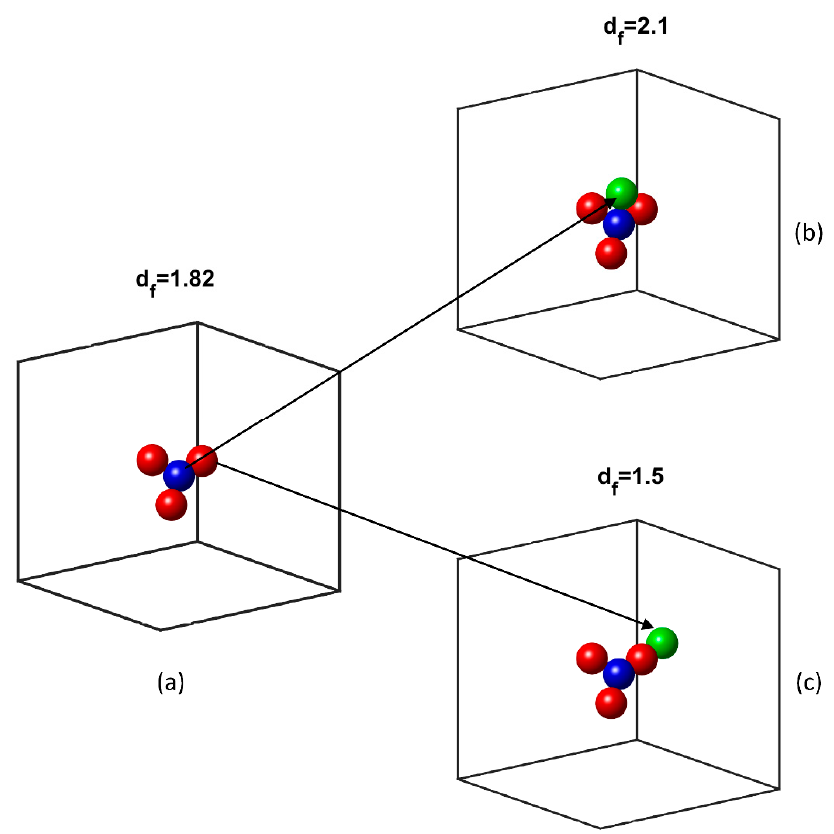
Figure 1. ( a ) Categorisation of particles into internal (blue) and external (red); addition of a new particle (green), which ( b ) increases the fractal dimension and ( c ) reduces the fractal dimension.